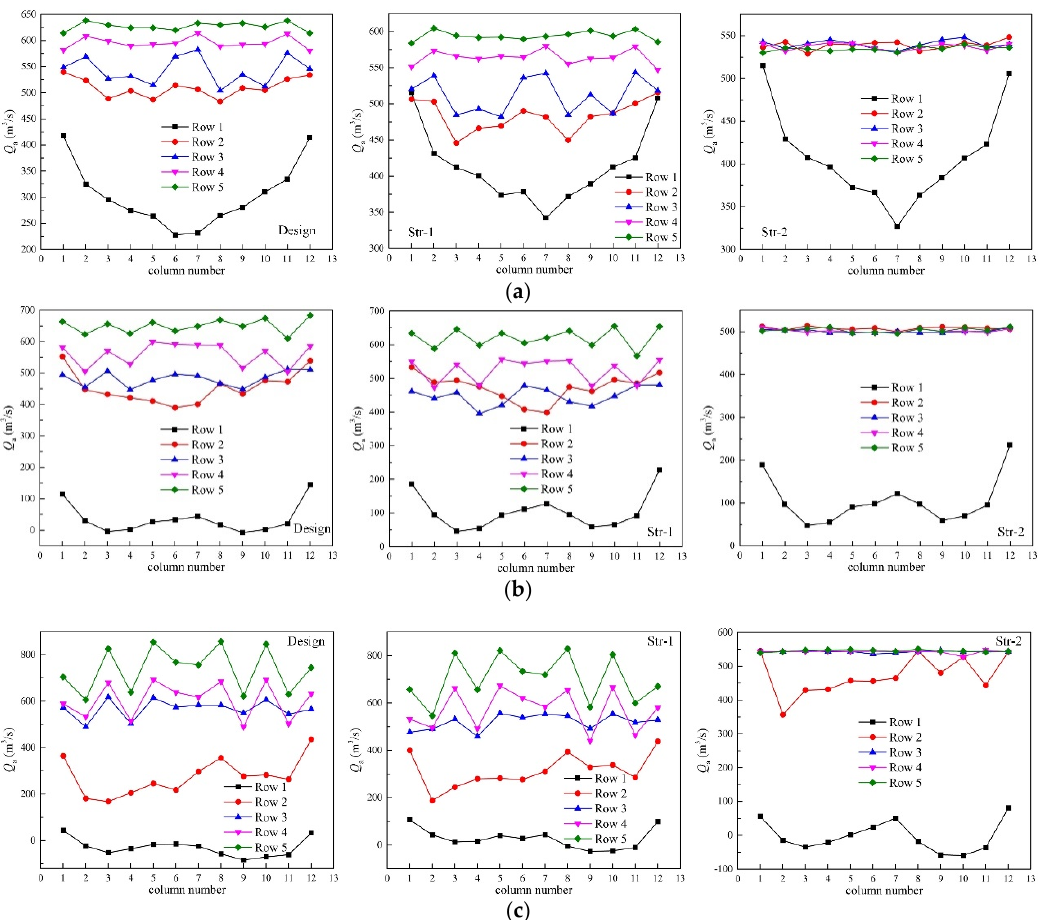
Figure 11. Volumetric flow rates of each fan for Design, Str-1, and Str-2 cases at different wind speeds: ( a ) 4 m/s; ( b ) 12 m/s; ( c ) 20 m/s.